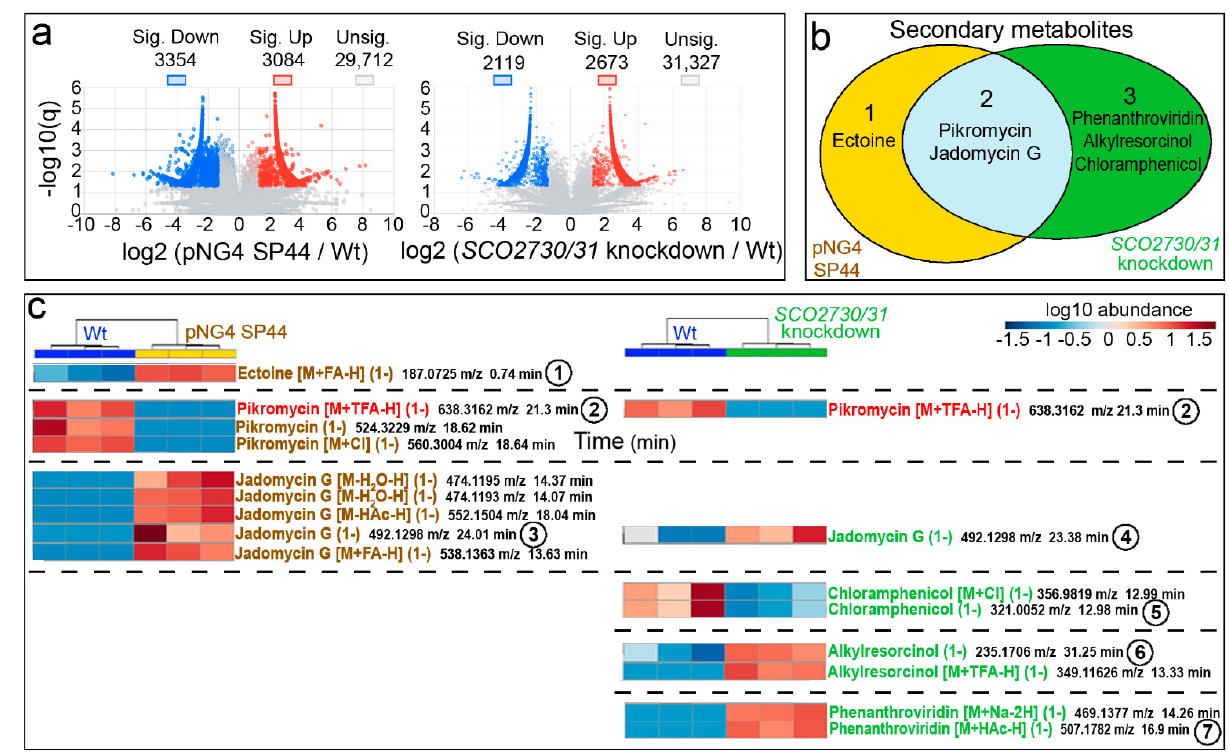
Figure 5. Metabolome analysis of the S. venezuelae SCO2730/31 knockdown mutant compared to the S. venezuelae wild- type-strain SP44. ( a ) Volcano plots of the abundance of the compounds detected in each strain compared to the wild-type strain. Significant up- (red) and down-regulated (blue) compounds are indicated. ( b ) Venn diagram showing the putatively identified secondary metabolites, showing significantly affected production in the SCO2730/31 knockdown mutant and the pNG4-SP44 strains compared to the wild-type strain. ( c ) Heat map showing the abundance values of the putatively identified secondary metabolite adducts and isomers, showing significant differences compared to the wild-type strain. The abundance values from three biological replicates are shown. The numbers indicate compounds whose chromatograms are indicated in Figure 6. The only adduct identified in the pNG4-SP44 and the SCO2730/31 strains is highlighted in red.